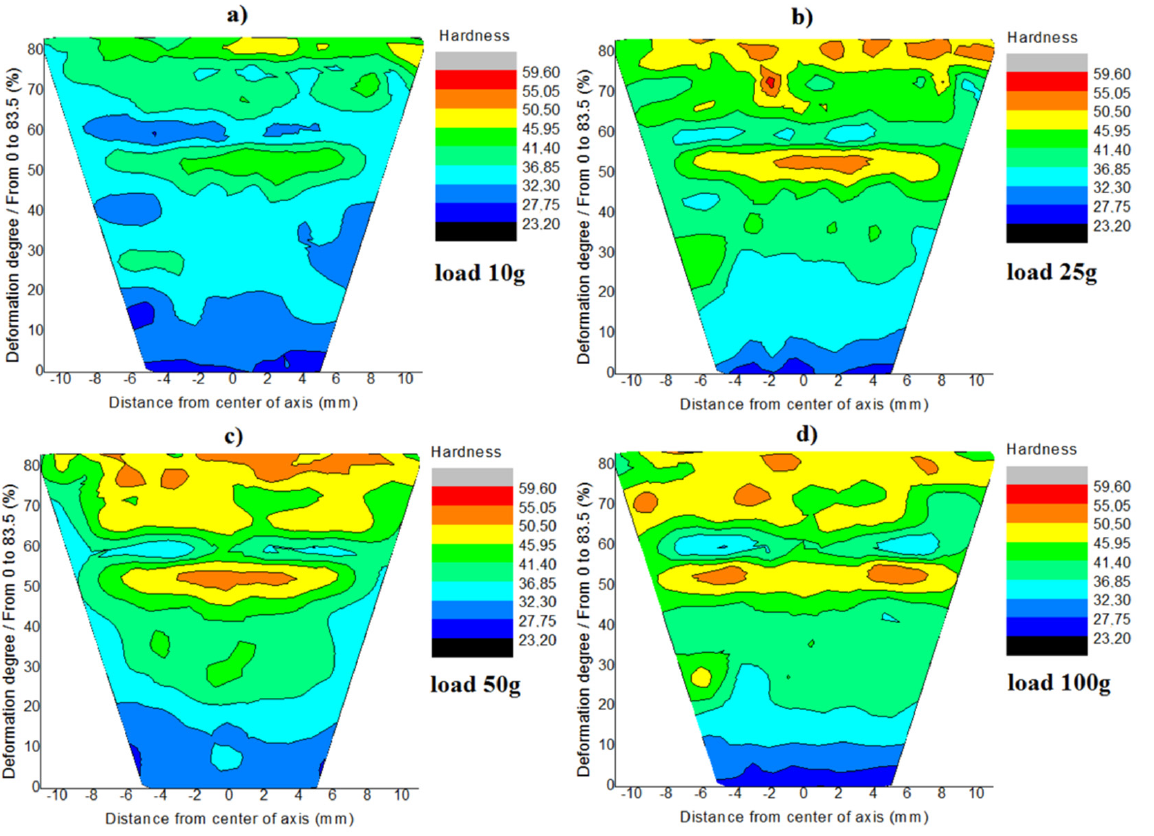
Figure 8. Compressed samples: the micro-hardness as a function of the degree of deformation and the load: ( a ) 0.09807 N, ( b ) 0.24518 N, ( c ) 0.49035 N, and ( d ) 0.9807 N.